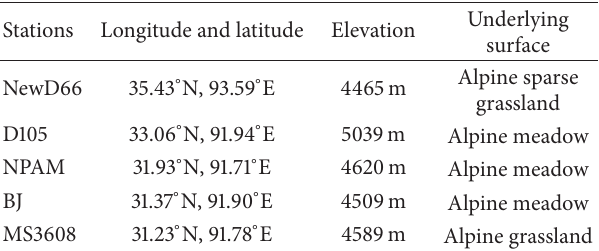
Table 1: The basic information of all